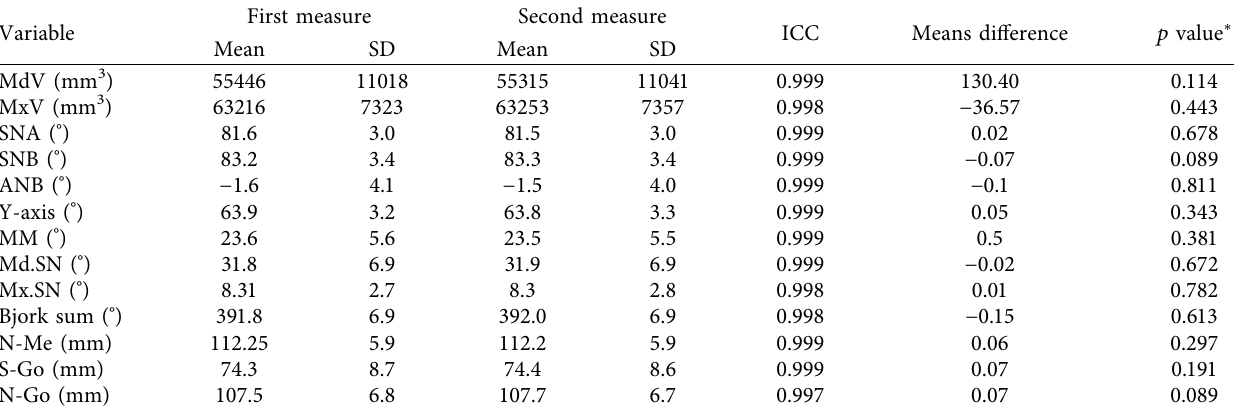
Figure 6: The volume of the maxillary bone shown in the 3D properties box (highlighted in yellow). In addition, the 3D objects are shown in the window for both the mandible and the maxilla. Table 2: Assessment of the intraobserver reliability and error of the method.